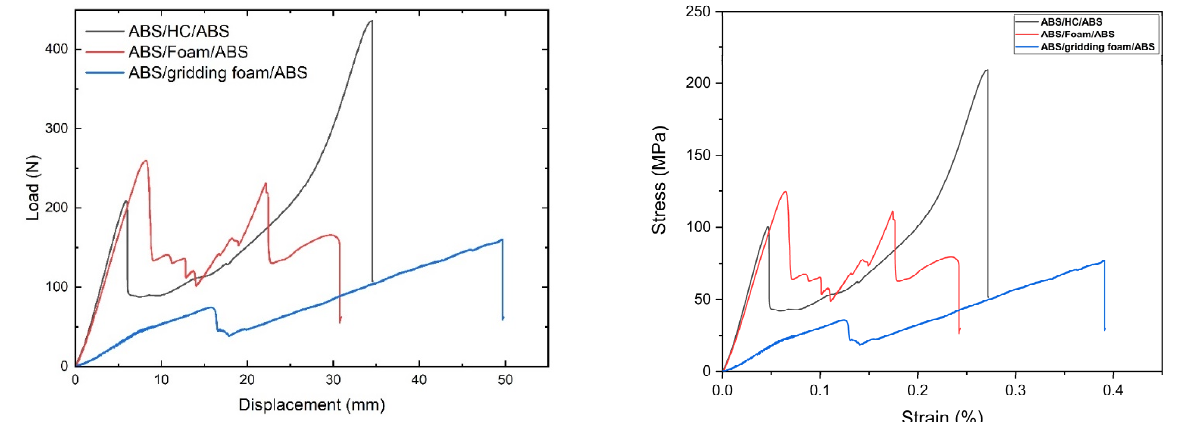
Figure 12. Representative load vs. displacement ( left ) and stress vs. strain ( right ) curves registered during the bending tests of: ABS/HC/ABS (green line), ABS/Foam/ABS (red line), and ABS/gridding foam/ABS panels (blue line).